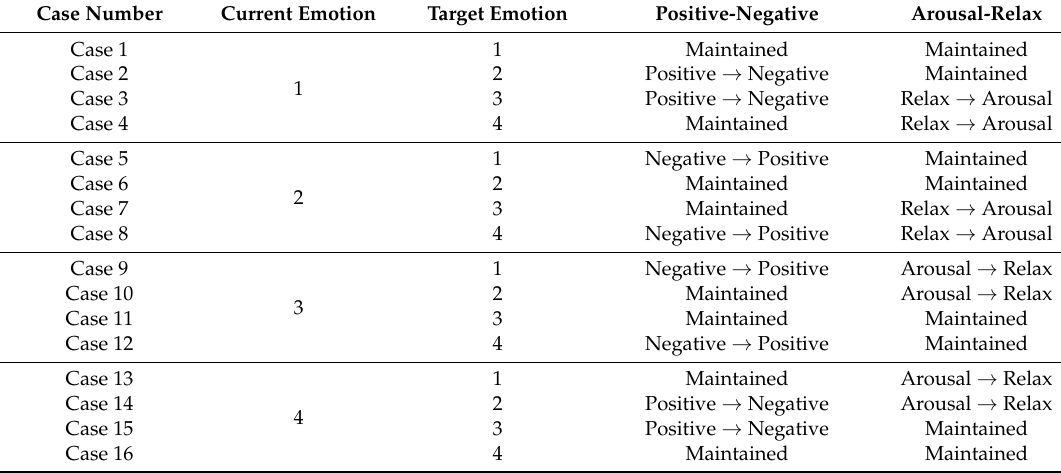
Table 10. Emotion change cases.